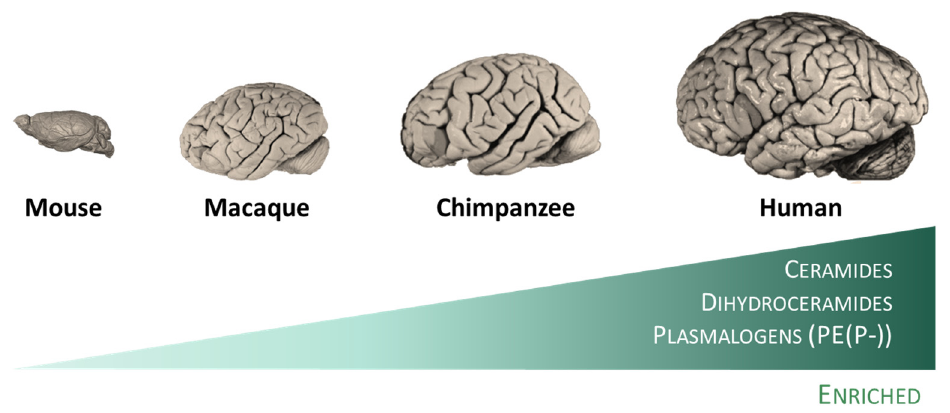
Figure 2. The human brain possesses specific traits at the lipidome level. Among mammalian species, humans included, lipidomes systematically distinguish the brain from the non-neural tissues [47]. This specific lipidome includes an enrichment in ceramides, dihydroceramides, and plasmalogens, and a depletion in fatty amides, triradylglycerols, and sterols. Notably, the extent of differences in the lipidome composition between the brain and non-neural tissues increases in parallel with the increase in the brain function capacity from mice to humans.